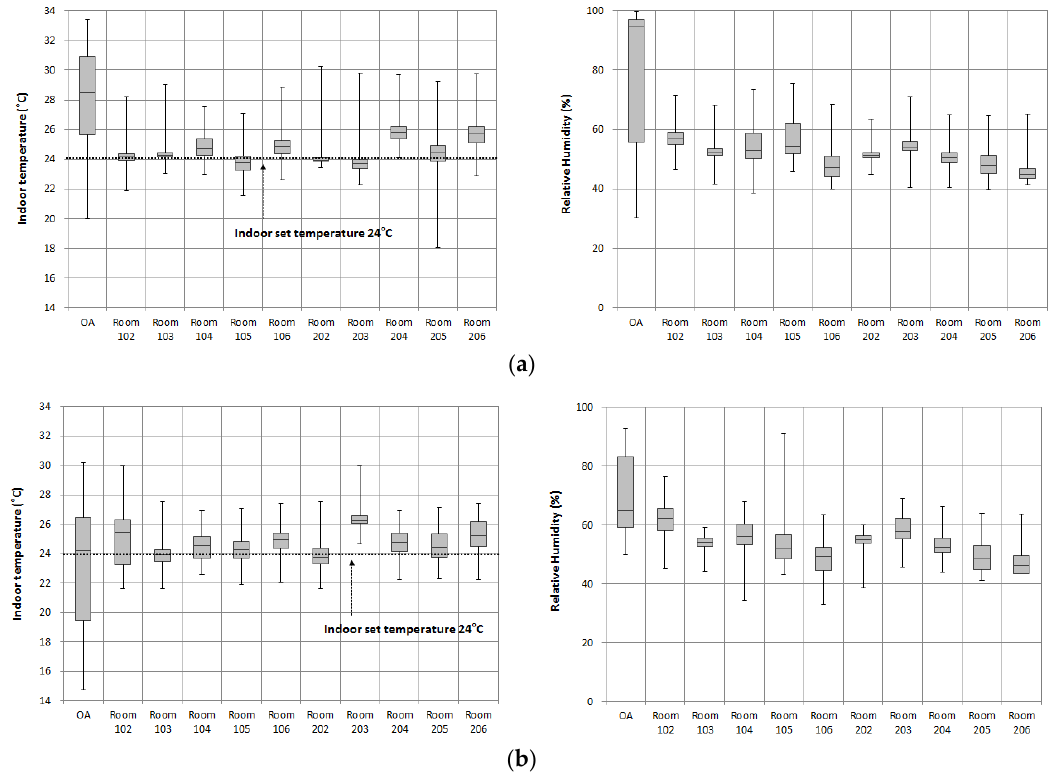
Figure 11. Comparison of indoor temperature and relative humidity; ( a ) Conventional control (Indoor Temperature, Indoor Relative Humidity); ( b ) Algorithm (Indoor Temperature, Indoor Relative Humidity)